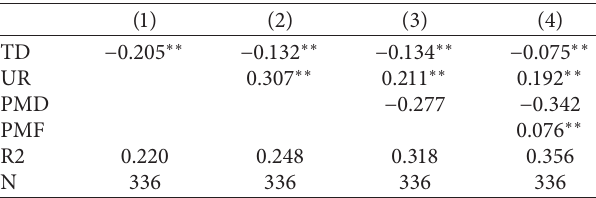
Table 5: Panel regression results of GDP per capita (in log) in Xinjiang,